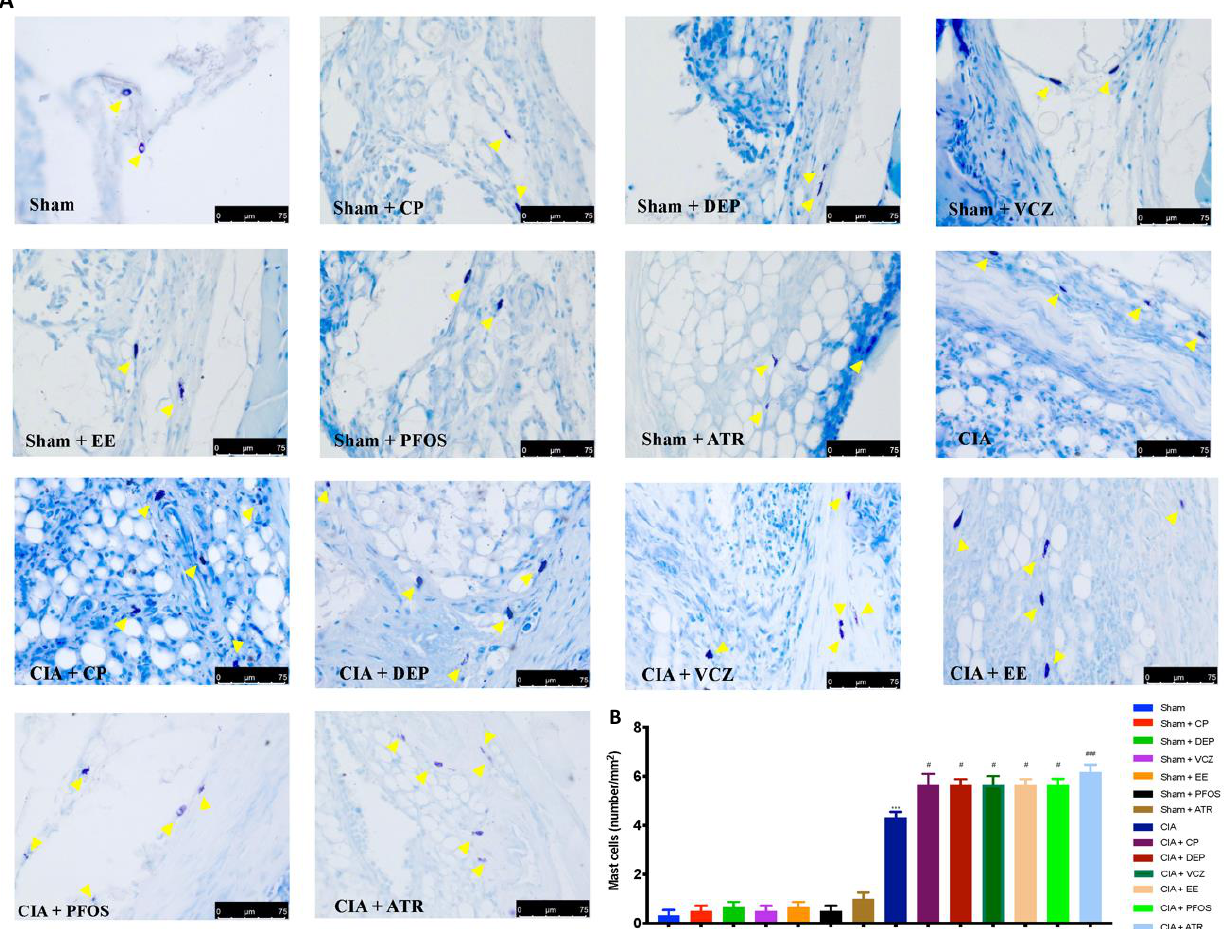
Figure 7. Evaluation of mast cells by toluidine blue staining ( A ); mast cell count ( B ). A 40× magnifi- cation is shown (75 µm scale bar). Yellow arrows indicated mast cells. *** p < 0.001 vs. sham; # p < 0.05 vs. CIA; ### p < 0.001 vs. CIA.